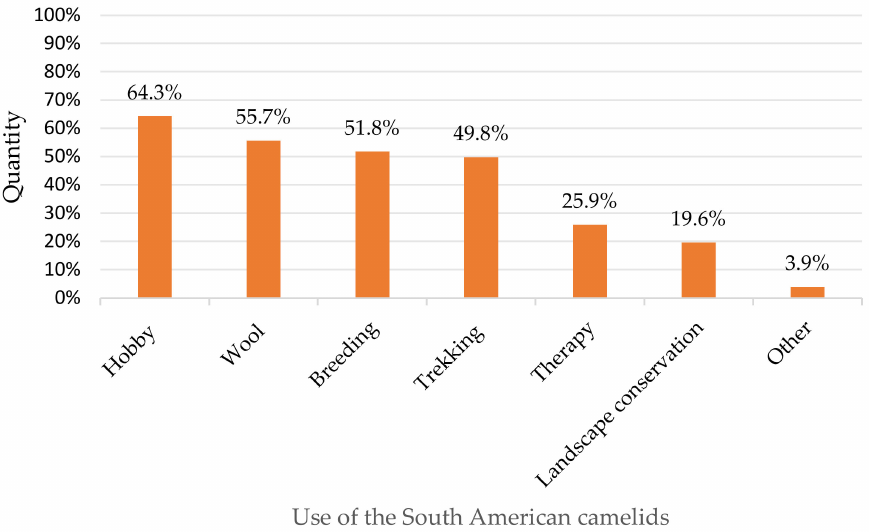
Figure 3. Use of South American camelids (multiple choice; n = 255; for explanation “other” see Document